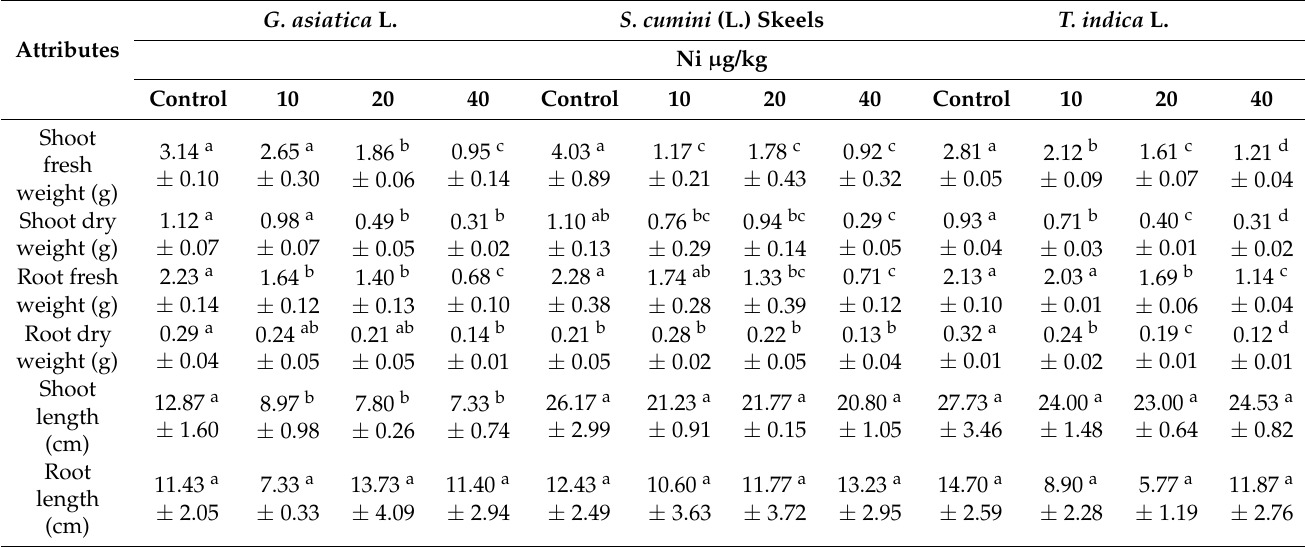
Table 1. Mean values ( ± S.E.) of tissue (shoot and root) growth of three minor fruit species ( Grewia asiatica L., Syzgium cumini (L.) Skeels and Tamarindus indica L.) following exposure to various levels of Ni.